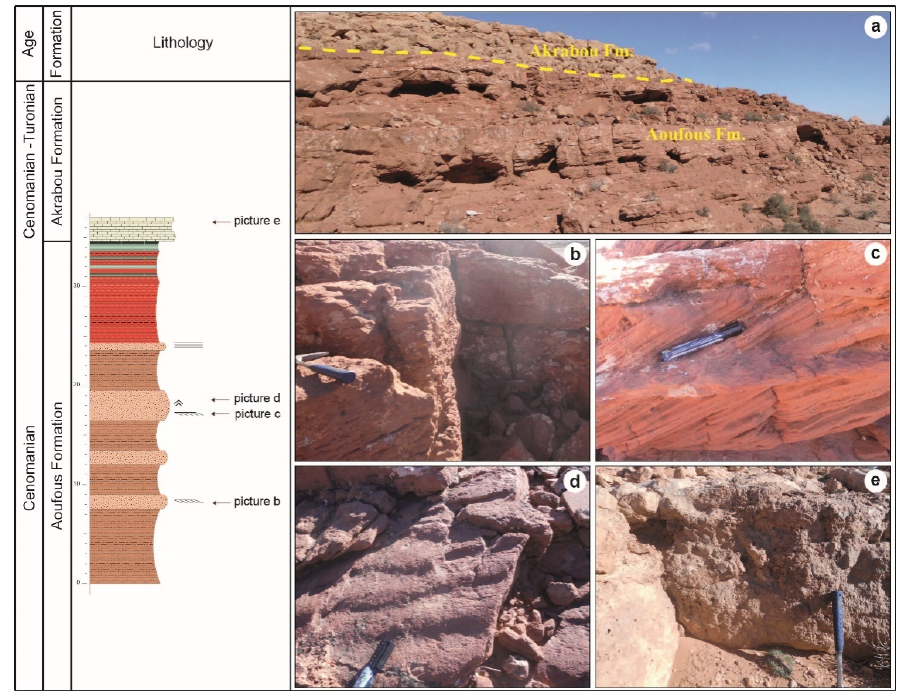
Figure 11. Imiter section. ( a ) general view of the series; b, metric sandstone bed with oblique lam ‐ ination; ( c ) cross ‐ sectional view showing a sandstone with oblique lamination framed by horizontal bedding; ( d ) the top surface of sandstone with wave ripples; ( e ) a cross ‐ section of the carbonate unit, note the significant reduction in thickness when compared to previous sections.